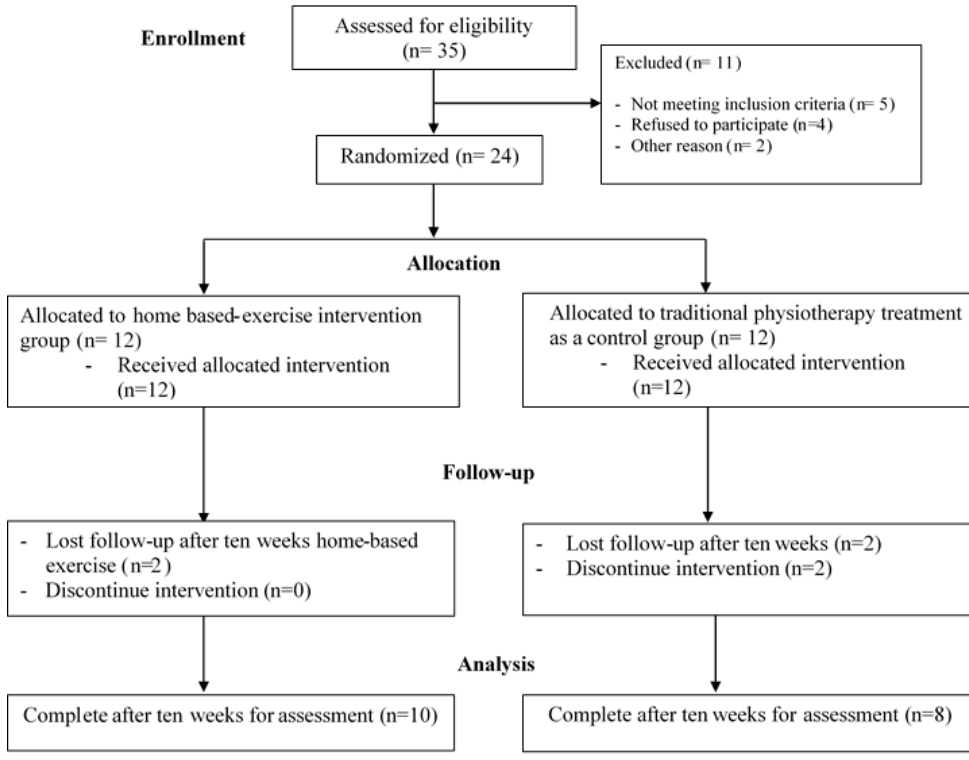
Figure 1. CONSORT diagram for this